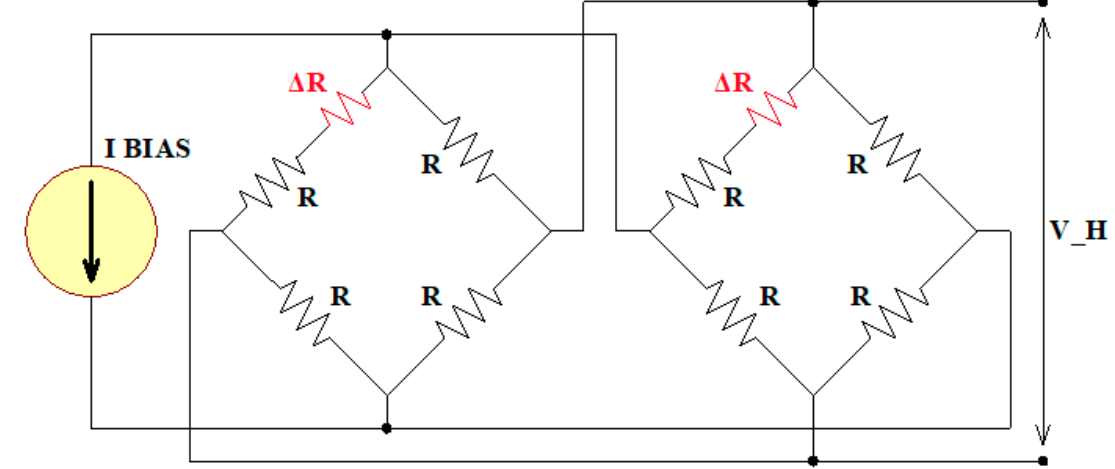
Figure 1. Pairing of two matched sensors being connected electrically in parallel but having orthogonal current